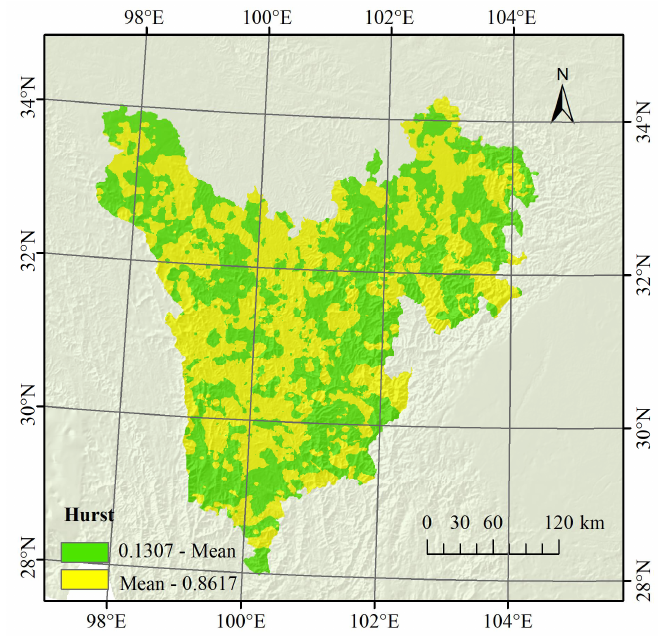
Figure 9. The persistence of VNPP trends test.